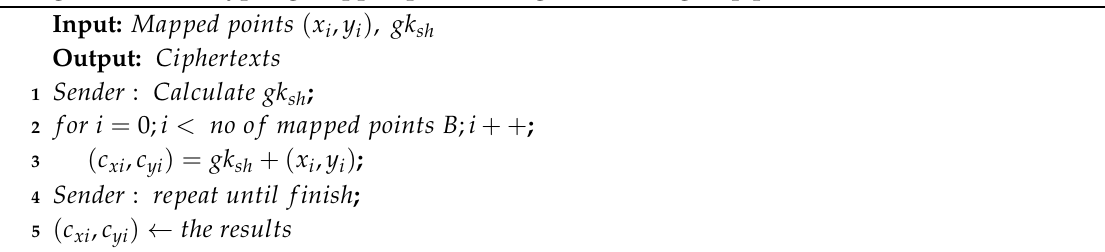
Algorithm 7: Encrypting mapped points using the shared group